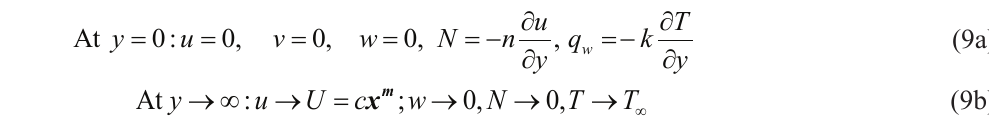
Case 1: Generalized two-dimensional wedge flow for which 0 < β* < 2 i.e. m >